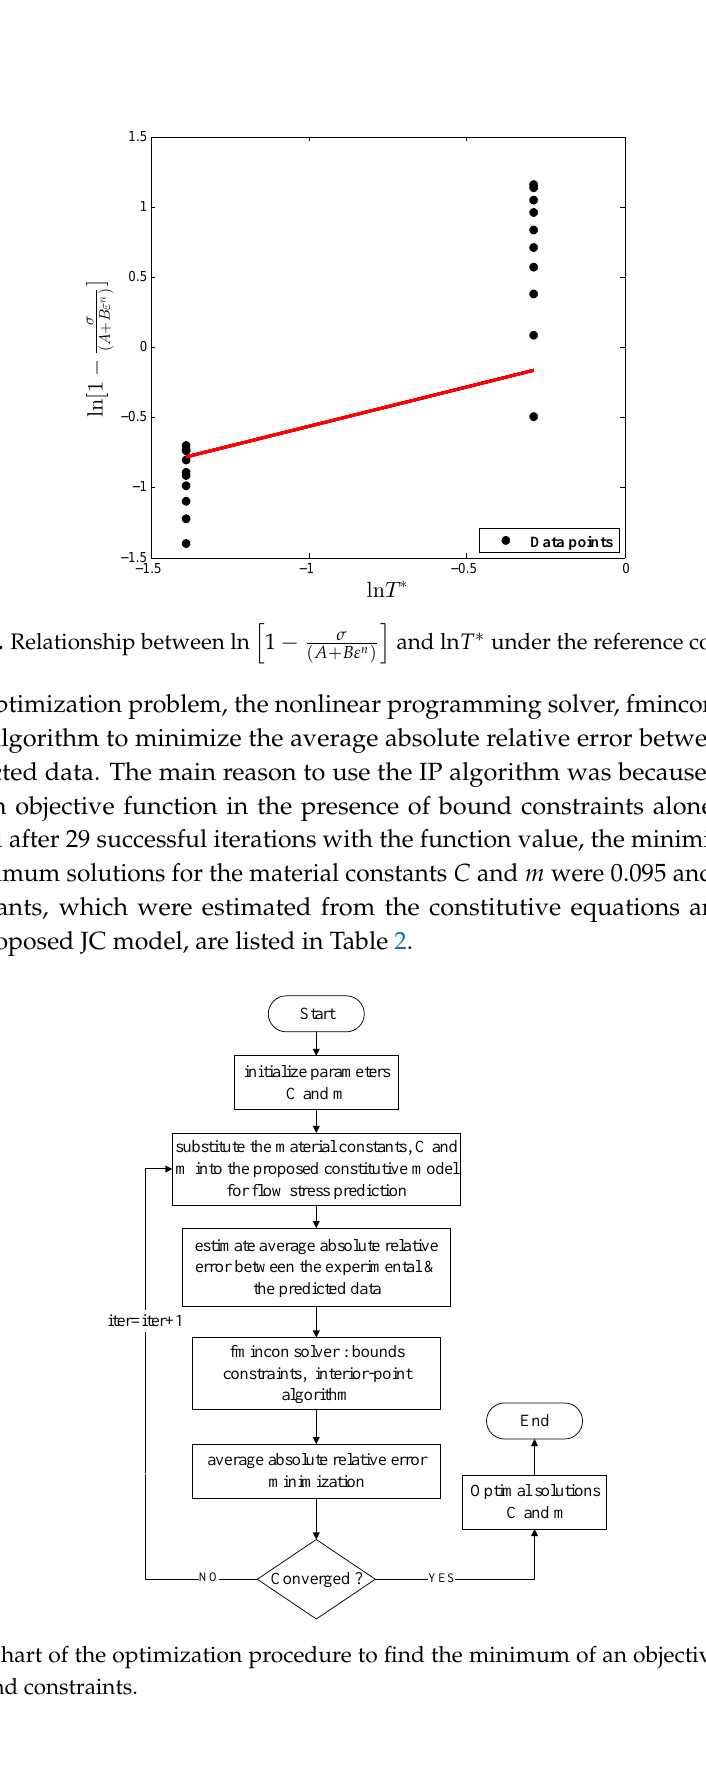
Figure 6. Flow chart of the optimization procedure to find the minimum of an objective function in the presence of bound